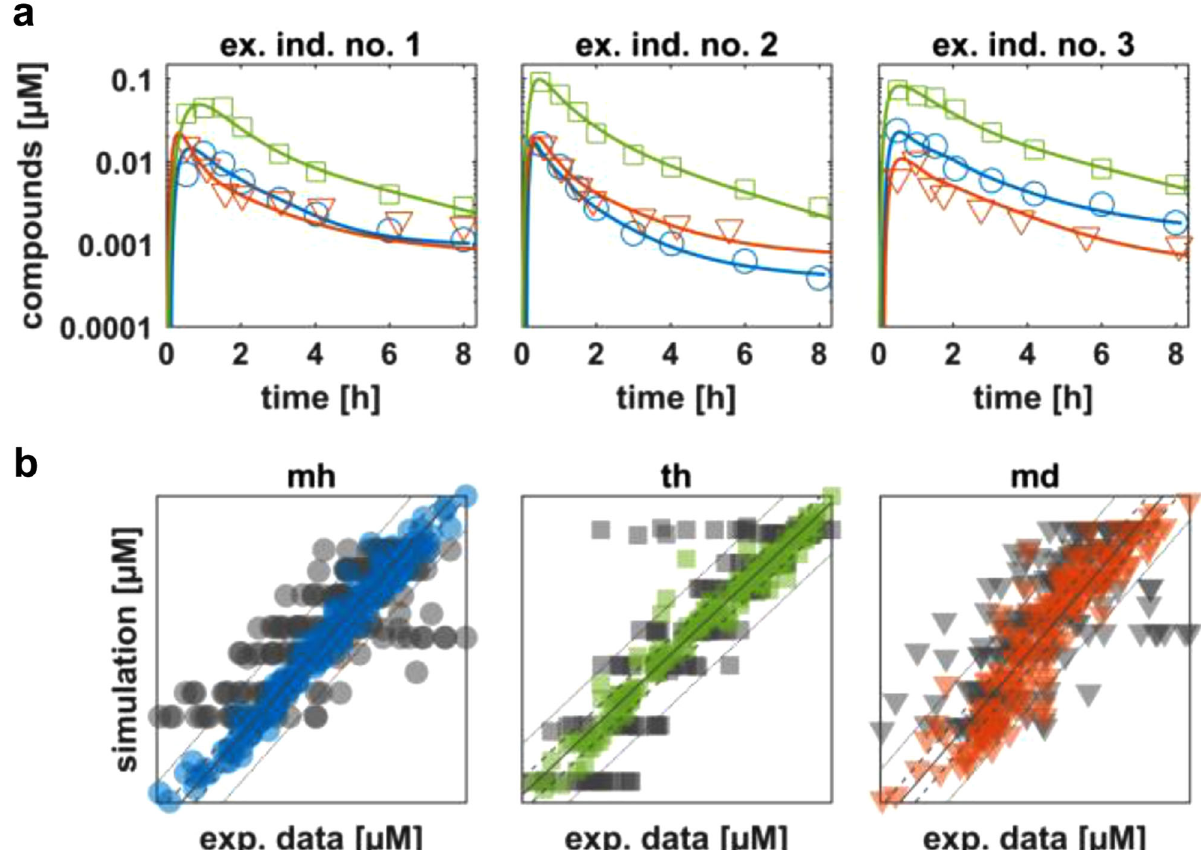
Fig. 3 Individual model simulations after application of the three learning steps of the translational approach. a Simulations of venous blood plasma concentration based on parameters with maximum posterior probability are shown for three example individuals. b Comparison of experimental data of venous blood plasma concentration with simulations of the mean value model (start parameterization) at experimental time points ( gray ), and experimental data from simulations with individual-speci fi c parameterized models (based on acquired distributions) at experimental time points ( colored ). Blue circles indicate midazolam data from healthy population (mh); green squares indicate torsemide data from healthy population (th); red triangles indicate midazolam data from diseased population